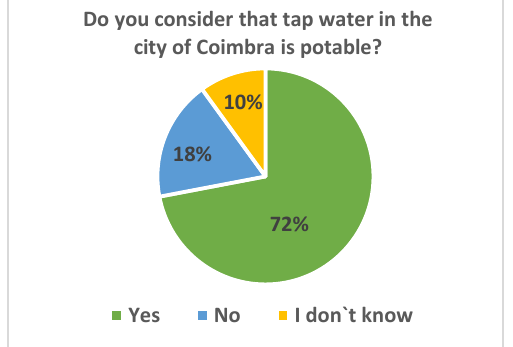
Figure 5. Perception of tap water quality.